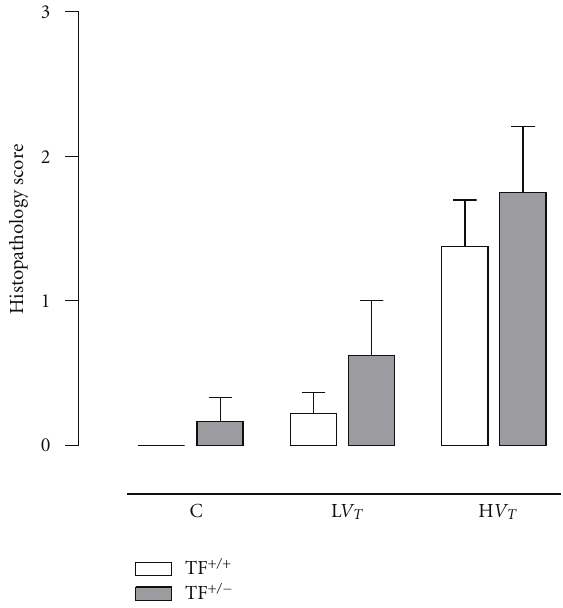
Figure 4: Histopathology scores in control mice (C) and mice ventilated for 5 hours with lower tidal volumes (L V T ) or higher VT (H V T ). Each group consisted of heterozygote TF knockout mice (TF + / − ) and their wild-type littermates (TF + / + ). Data represent means and SEM of six mice. Di ff erences between TF + / − and TF + / + are not statistically